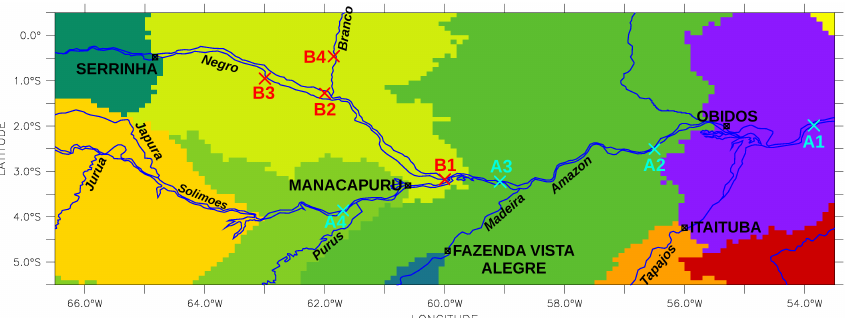
Fig. 16. Map of locations of virtual stations on Topex/Poseidon ground tracks available for the period 1993–2000: 4 locations on the mainstem (ID An with n =1 to 4 in light blue) and 4 locations on the Rio Negro-Branco (ID Bn with n =1 to 4 in red). See Table 8 for coordinates of the stations. Color is used to distinguish the different sub-basins.